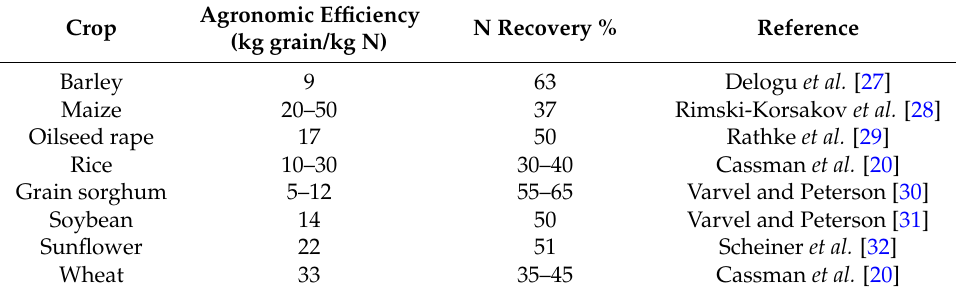
Table 1. Outlook of agronomic efficiency and N recovery of major crops around the